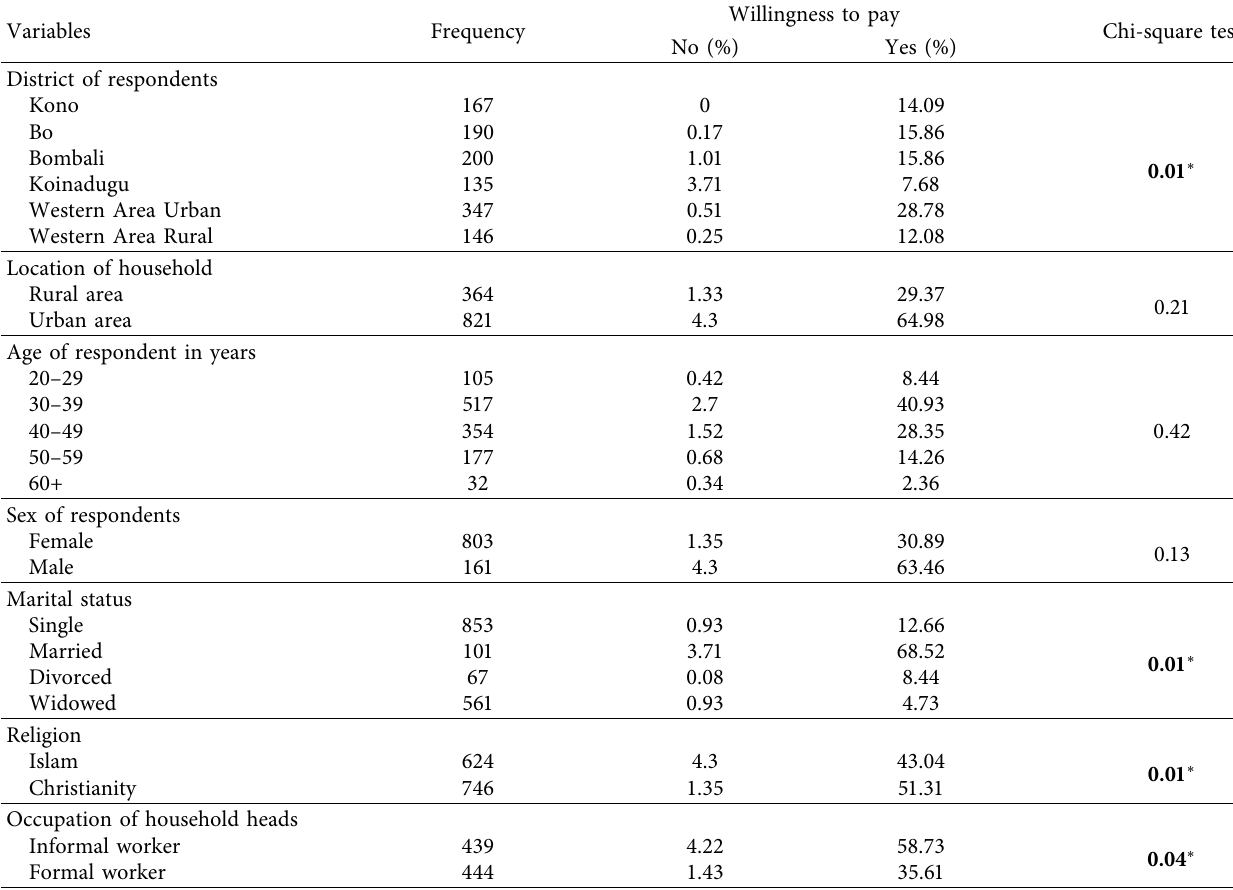
Table 3: Chi-square test of independent